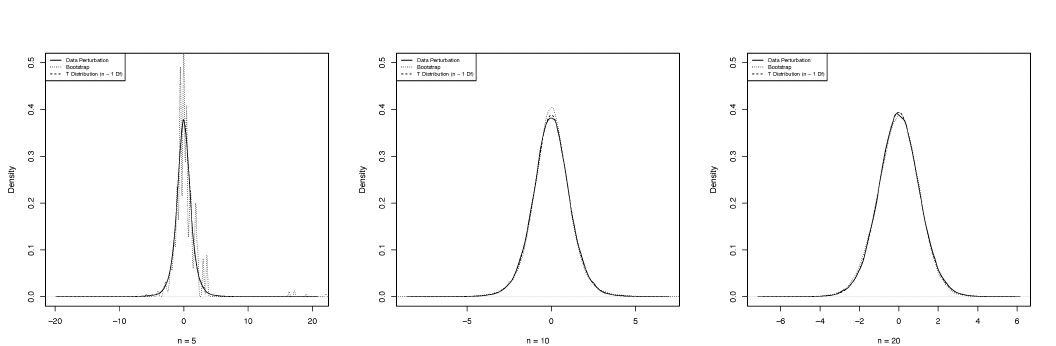
Figure 1. Illustration of the exact distribution of pivotal for three sample sizes n = 5 , 10 , 20 based on simulated data. Pivotal’s densities for data flush with a Monte Carlo size 10 5 , nonparametric bootstrap with a bootstrap size 10 5 , and the t -distribution on n − 1 degrees of freedom are represented by solid, dot, and dash curves,